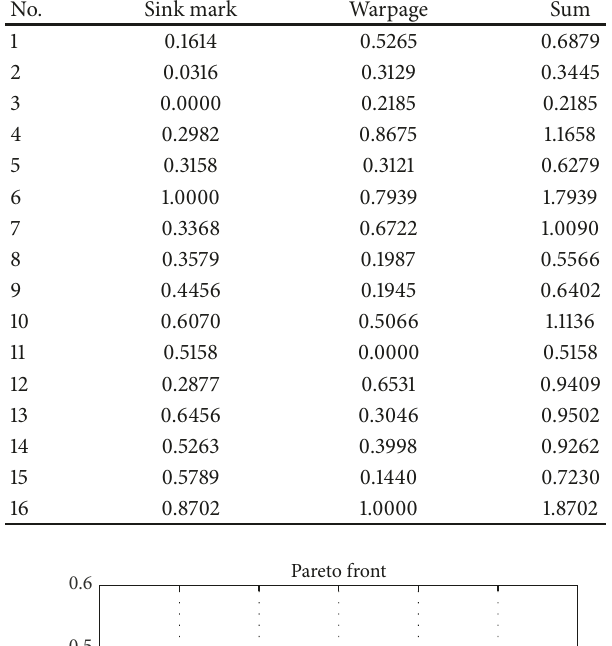
Table 4: Fuzzy mapping of the orthogonal results.